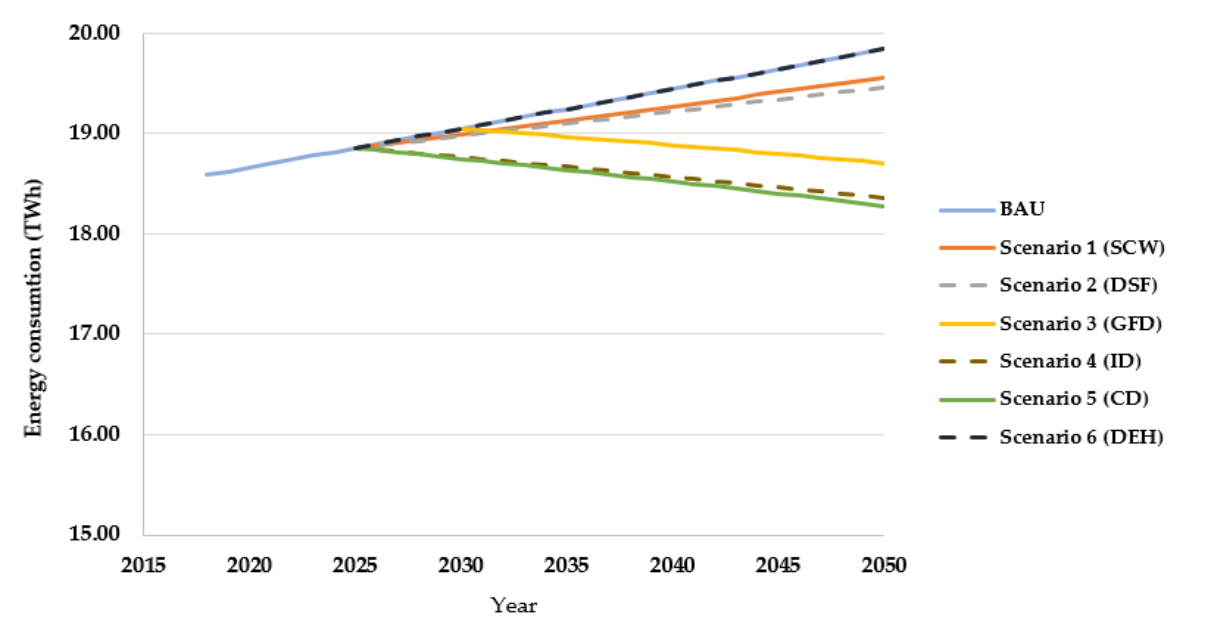
Figure 8. Projection of CO 2 emissions in the BAU (business as usual) scenario and paper produc- tion trend of the Austrian P&P sector.